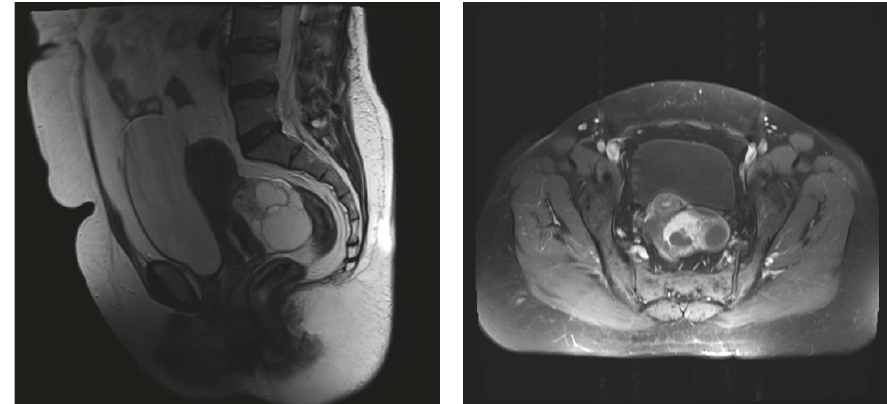
Figure 2: On contrasted MR a lesion measuring nearly 58 mm × 68 mm cyst with an increased signal intensity (30 HU), which fills Douglas recess and extends into the left adnexa. Initially the lesion was thought to be a left ovarian cyst but histopathology report demonstrated a